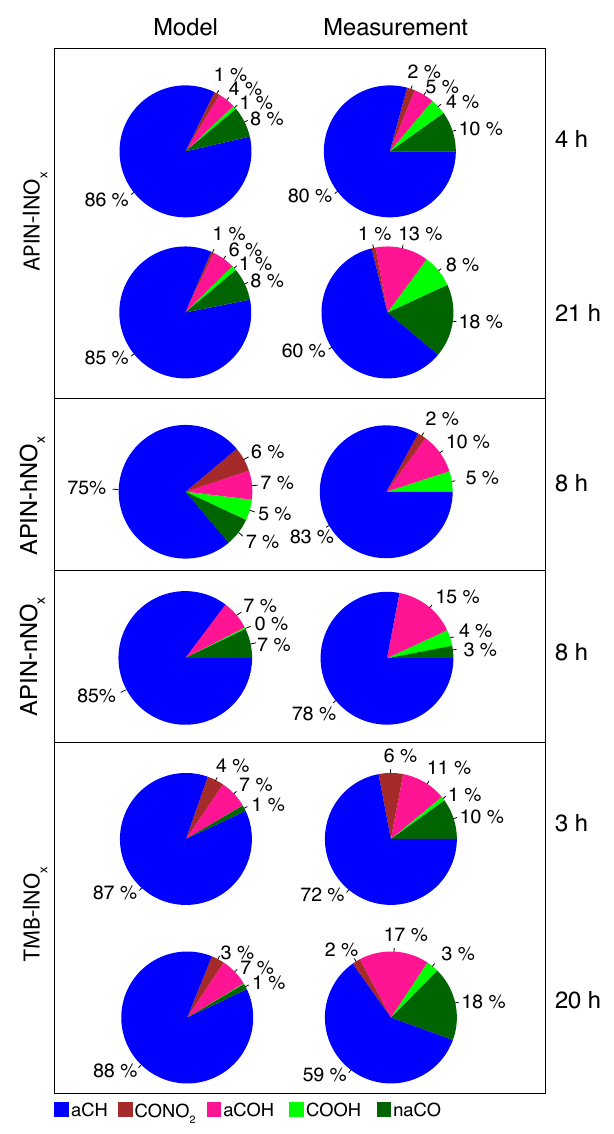
Figure 3. Pie charts illustrating the time-integrated relative aerosol mole fraction of aCH, CO, COOH, CONO 2 , and aCOH in model simulations and experiments. The mole fractions reported in sim- ulations are summed with respect to the subset of FGs that are re- ported by measurement to facilitate direct comparison. The time reported refers to the hours after the lights were turned on in the chamber (Measurements), and the time after the start of the simula- tion (Model). In the pie charts reporting the measurement conducted by Chhabra et al. (2011) (APIN-hNO x and APIN-nNO x ) the CNH 2 fraction has been omitted in order to obtain a direct comparison be- tween model and experiments. The sum of percentages combines to 100 ± 1%, as individual values were rounded to the nearest whole number for